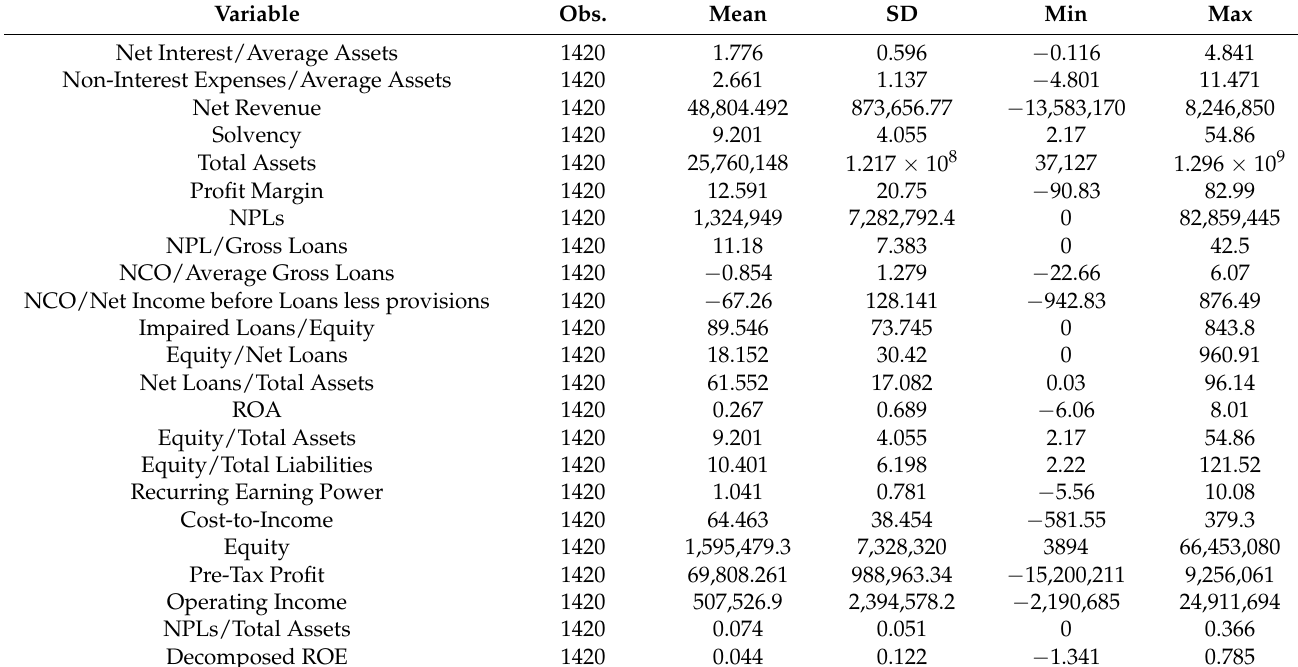
Table 1. Descriptive statistics for the 142 Italian banks (entire period 2011 to 2020). Authors’ development on data sourced from ORBIS—Bureau Van